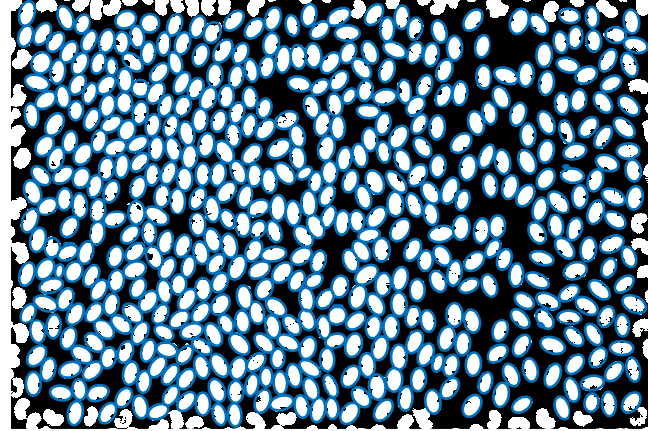
Figure 7. Micrograph of kidney bean fibers perpendicular to the viewing plane.